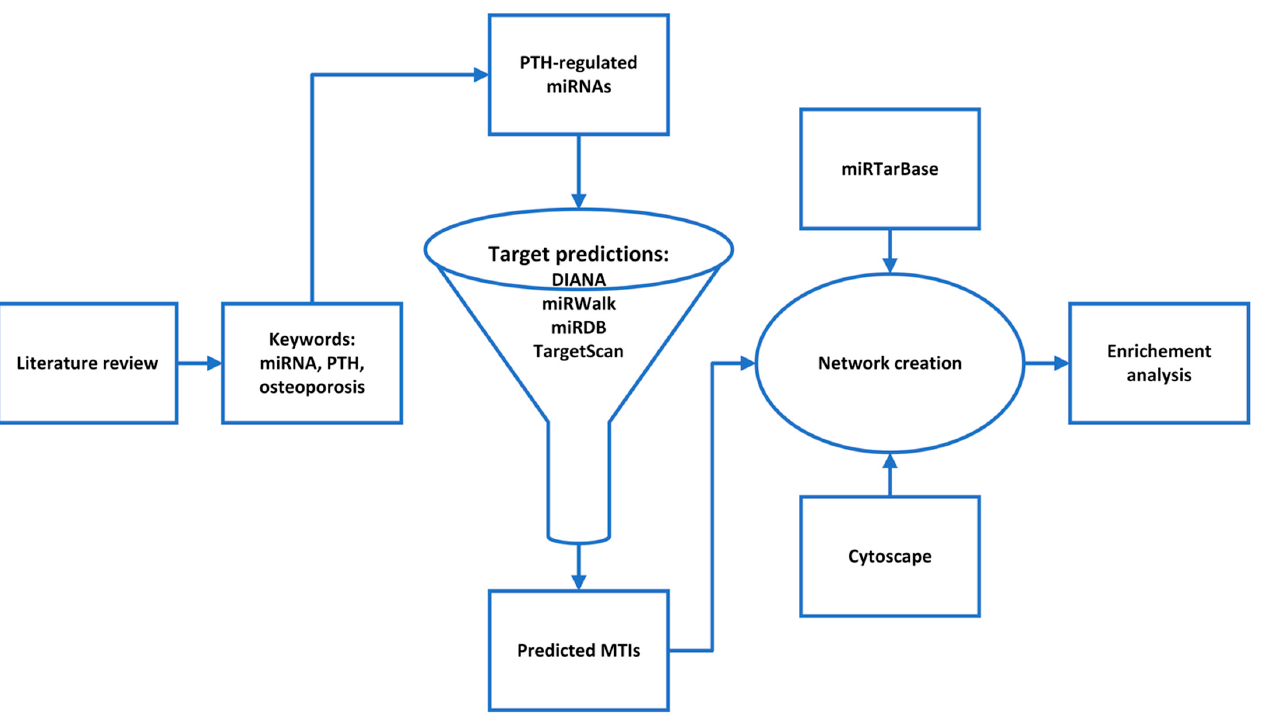
Figure 1. A flowchart of the study design.